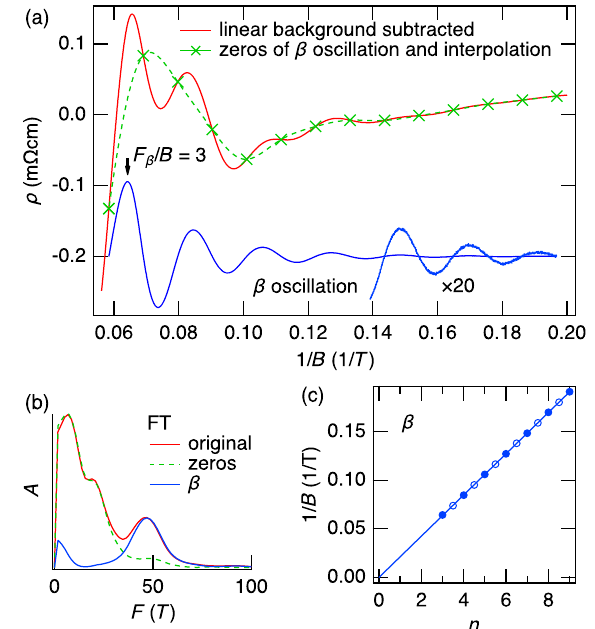
FIG. 6. (a) Oscillatory part of the resistivity for B ∥ c as a function of 1 =B (solid curve). The original data are the same as those of Fig. 3(a). The crosses are zeros of the β oscillation determined from d 2 ρ =dB 2 , and the connecting curve (dashed curve) is obtained by cubic spline interpolation. The β oscillation (lower curve, vertically shifted) is obtained by subtracting the interpolated curve from the original. (b) Fourier transforms of the original, interpolation,and β - oscillation curves. (c) Landau-index plot for the β frequency. Integer and half integer indices are assigned to resistivity maxima (solid circles) and minima (open circles),